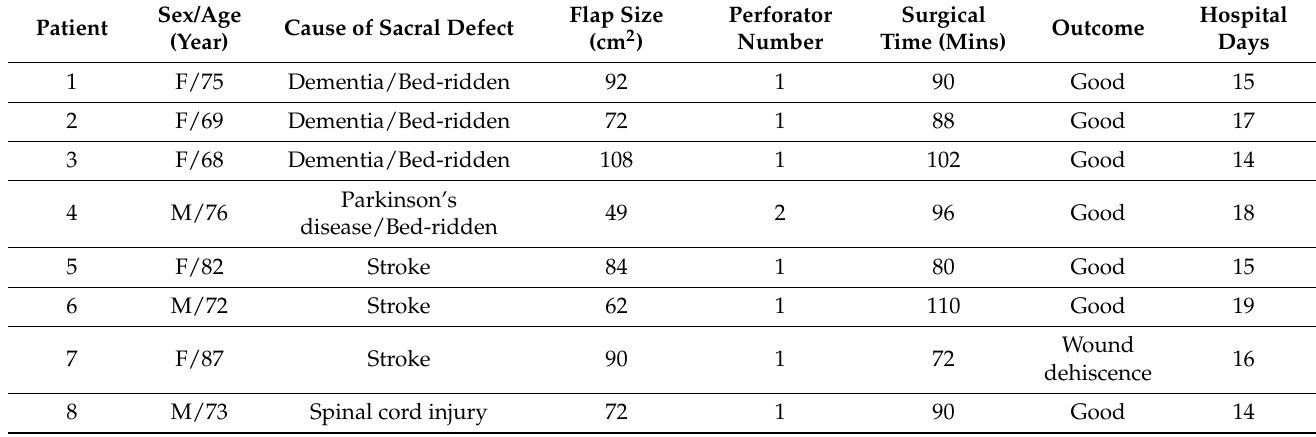
Table 3. Group 1.